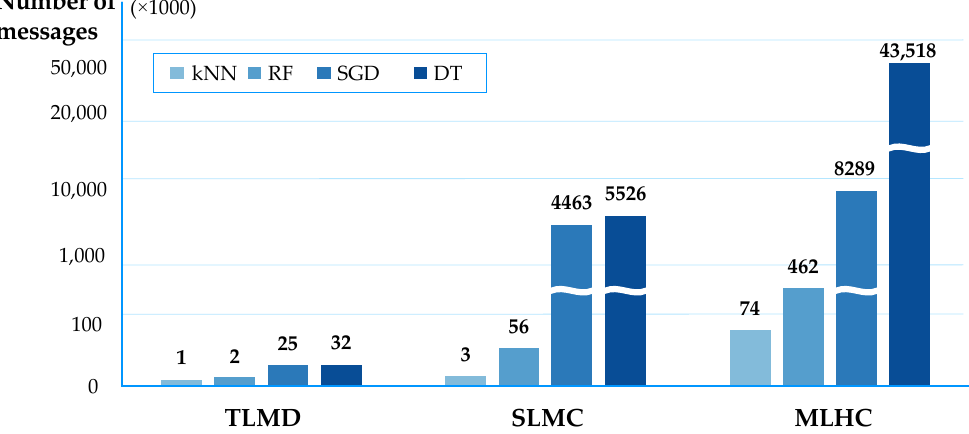
Figure 9. Simulation results: Number of CAN messages that can be processed per